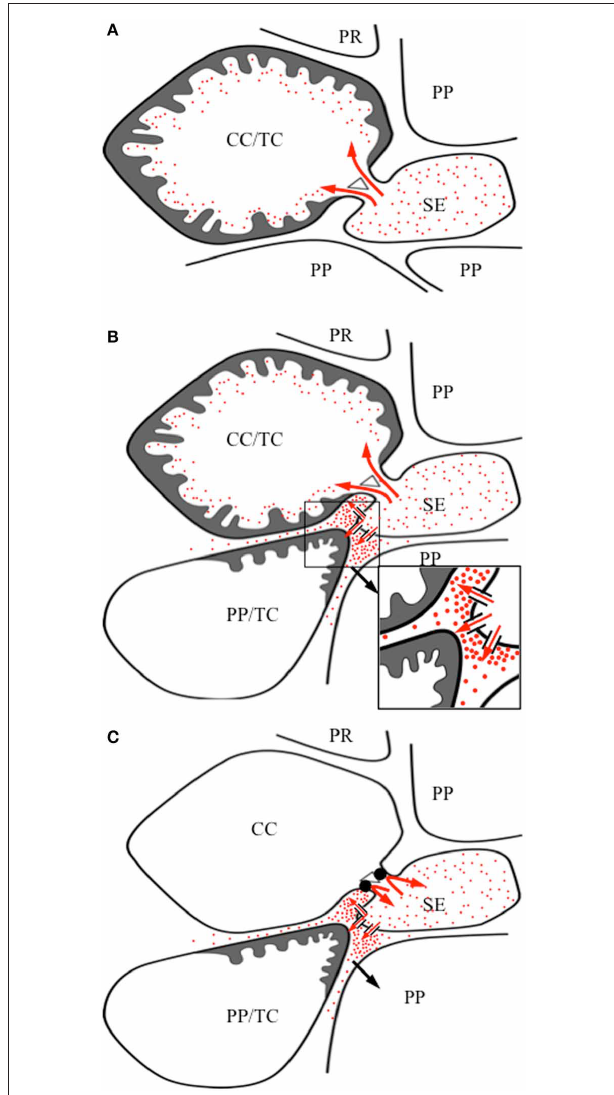
FIGURE 5 | Speculative model illustrating reactive oxygen species (ROS) mediated regulatory mechanisms that may account for observed patterns of inter- and intracellular formation of ingrowth walls (dark gray) in collection phloem companion cells (CC) and phloem parenchyma cells (PP) undergoing trans -differentiation to a transfer cell (TC) morphology. In all cases, developing sieve elements (SEs), undergoing partial programmed cell death, generate an intracellular ROS signal. (A) CC/TC trans -differentiation: SE-produced intracellular ROS (red dots) diffuses (thick red arrows) into CC, through interconnecting plasmodesmata, to induce formation of a non-polarized ingrowth wall covering the entire CC wall. (B) CC/TC and PP/TC trans -differentiation: an intracellular ROS signal induces ingrowth wall formation as described in (A) . In addition, intracellular ROS, released from developing SEs through plasma membrane aquaporins abutting adjacent PP (thin red arrows) into the shared SE/PP cell wall space, elicits a polarized formation of ingrowth walls proximal to SEs. (C) PP/TC trans -differentiation: A transient and excessive intracellular generation of ROS by developing SEs gates plasmodesmata interconnecting CCs closed (filled in) thus preventing transmission of the ROS signal (curved red arrows) across the developmental period in which CCs are otherwise ROS-responsive. Ingrowth wall formation in PPs occurs as described in (B)